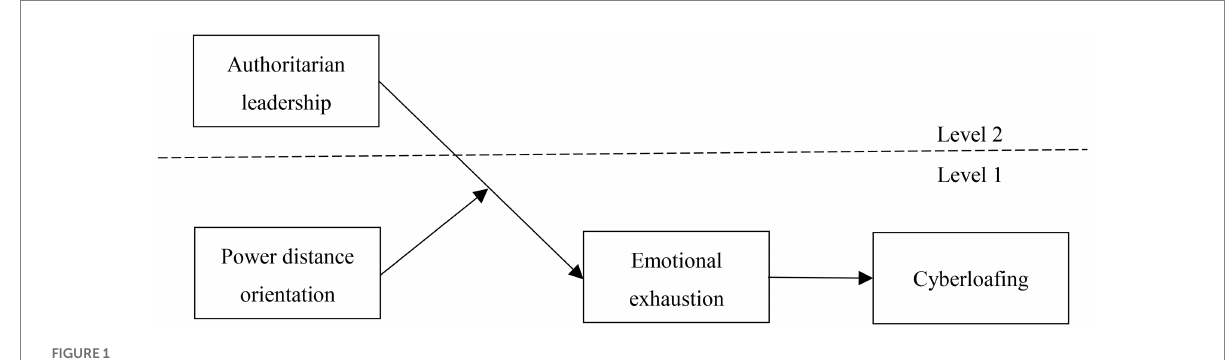
FIGURE 1 Theoretical